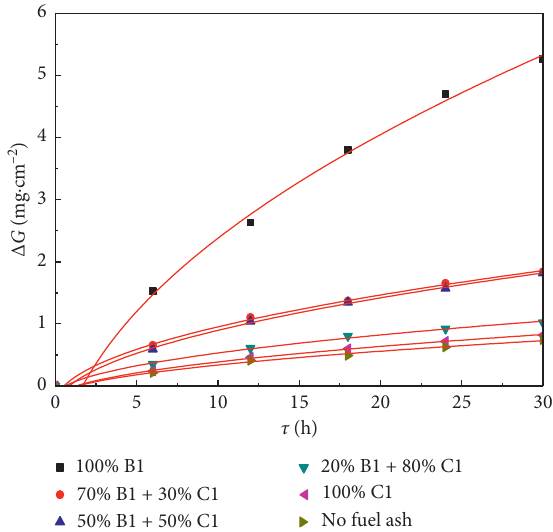
Figure 6: Curves of corrosion mass gain of metal samples coated with ash under different proportion of straw biomass blended to